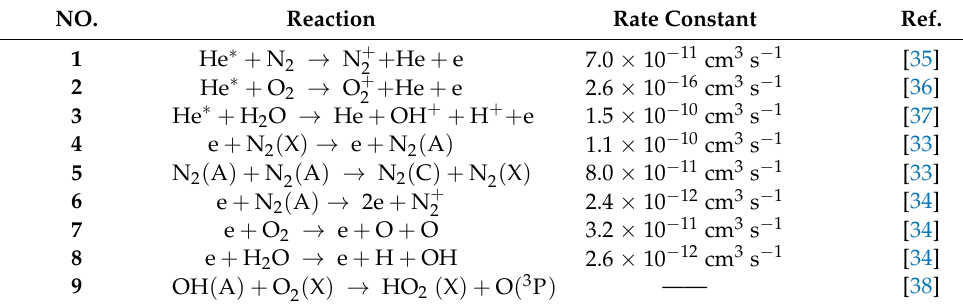
Figure 3. Typical optical emission spectrum generated by FEGLD plasma in the wavelength range of ( a ) 300–450 nm and ( b ) 450–800 nm. Table 1. Related reactions for active species in FEGLD.